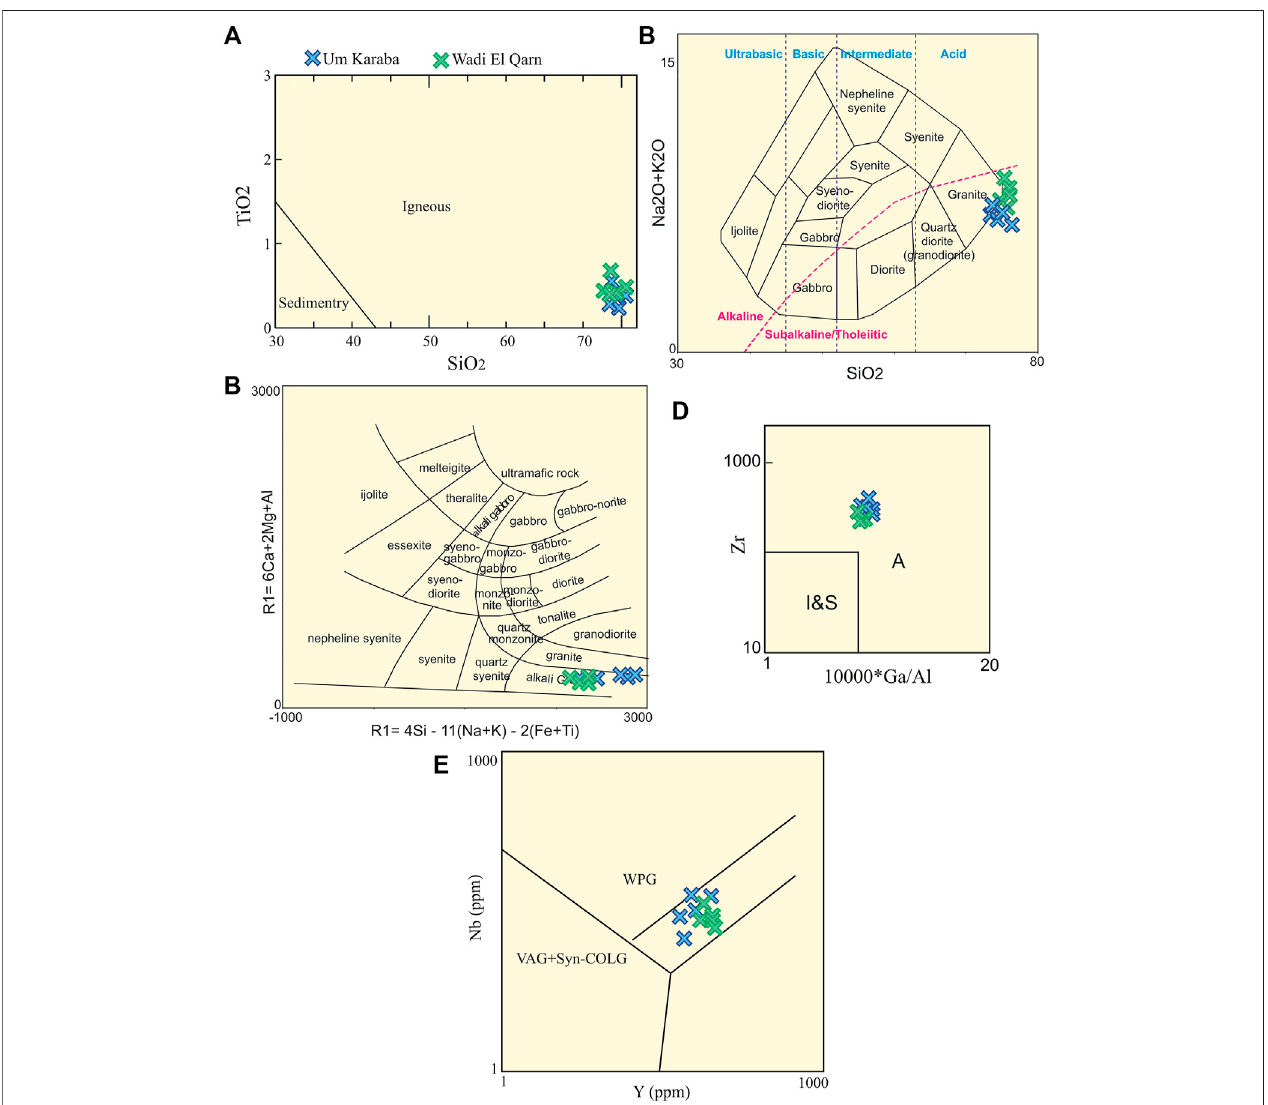
FIGURE13|(A) SiO 2 versusTiO 2 variationdiagramofTarney(1977).Discriminationdiagrams; (B) SiO 2 vs.,Na 2 O+K 2 OofCoxetal.(1979), (C) R1-R2diagramof De la Roche et al. (1980), (D) 10,000*Ga/Al vs. Zr, and (E) Y against Nb diagram of Pearce et al. (1984).